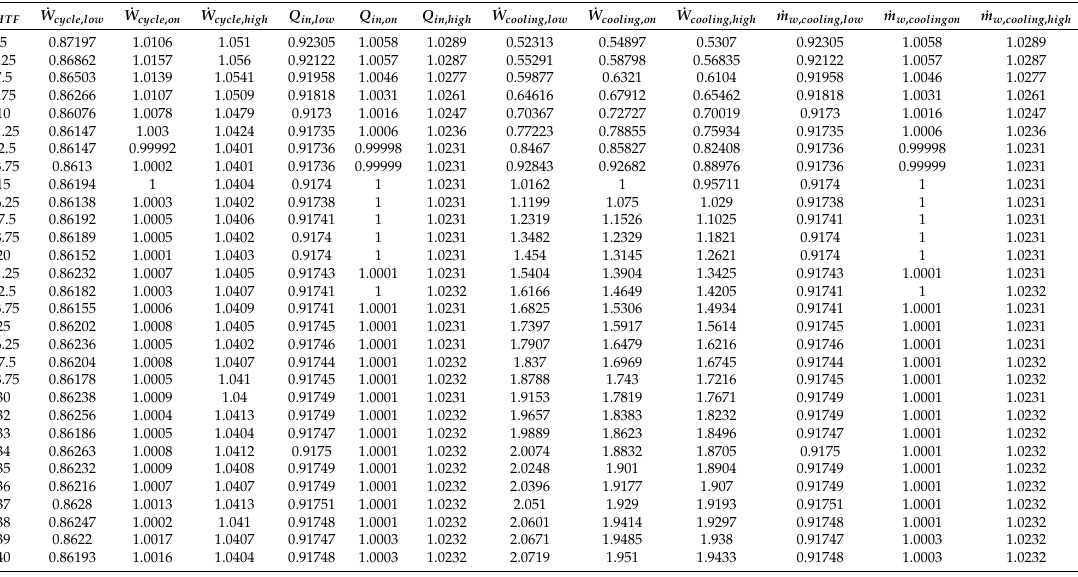
Table A6. Performance as a function of ambient temperature (MOD3) table for Partial Cooling cycle. “Low”, “On” and “High” respectively refer to the three values of molten salt (hot) temperature levels employed: 700, 770 and 800